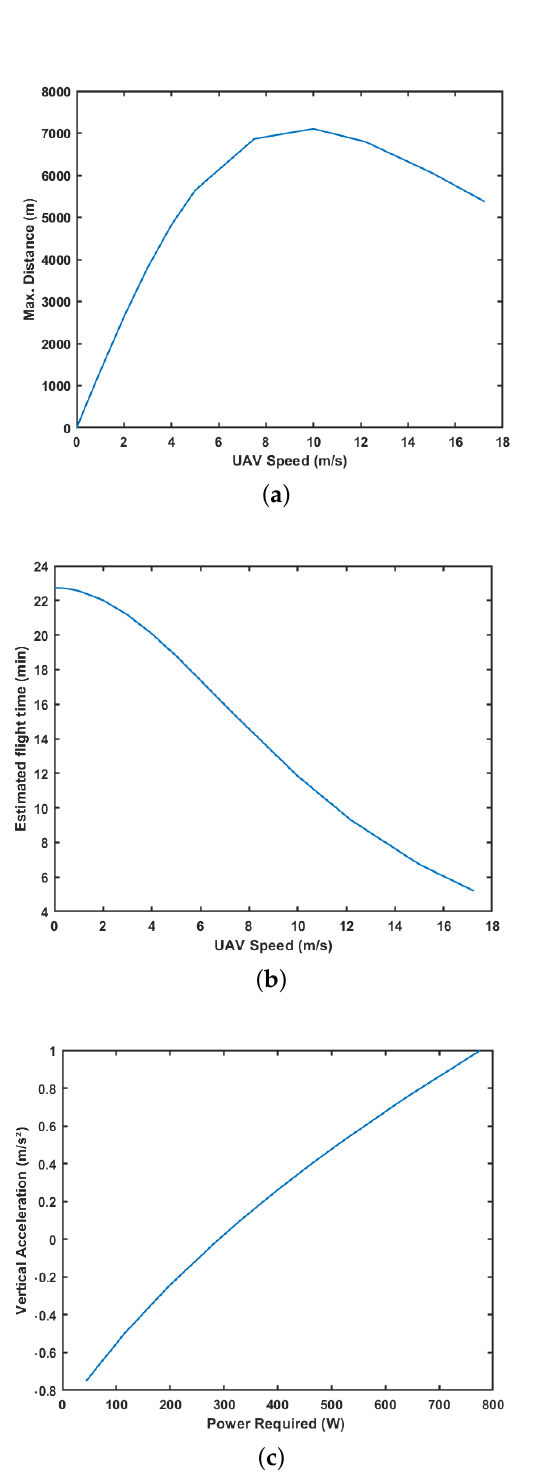
Figure 10. Unmanned Aerial Vehicle (UAV) flight characteristics for a 110 W/h battery. ( a ) Maximum distance traveled. ( b ) Maximum flight time. ( c ) Power required to accelerate